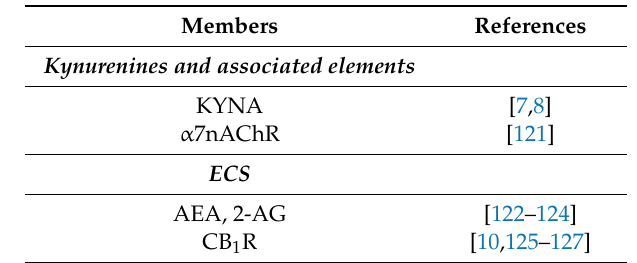
Kynurenines and associated elements (enzymes, receptors) and members of the ECS participating in glutamatergic, dopaminergic, and GABAergic neurotransmission associated with